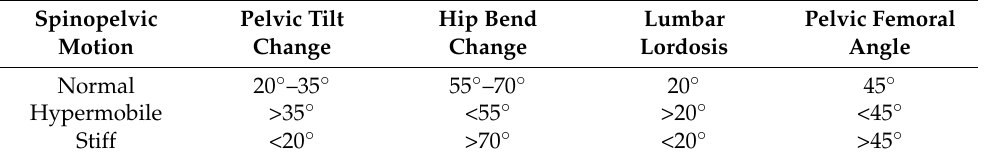
Table 1. Spinopelvic mobility types.